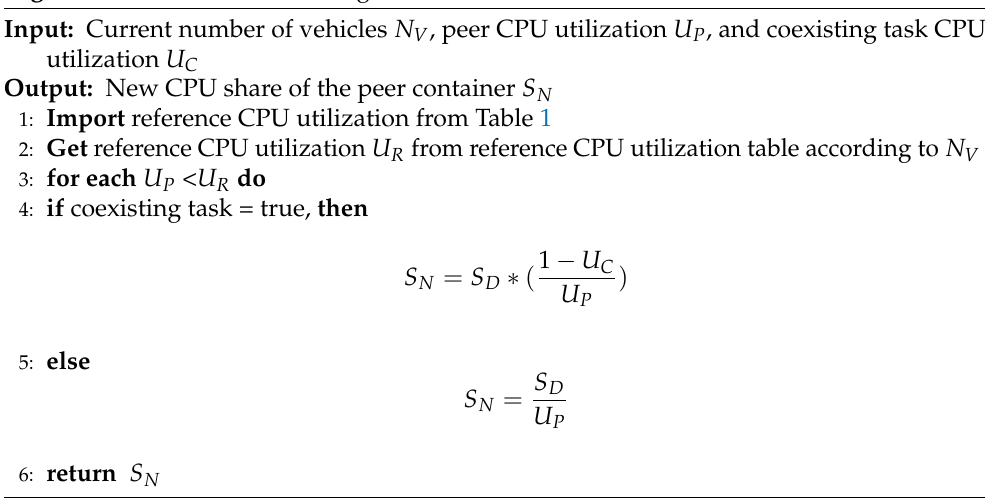
Algorithm 1 Resource control